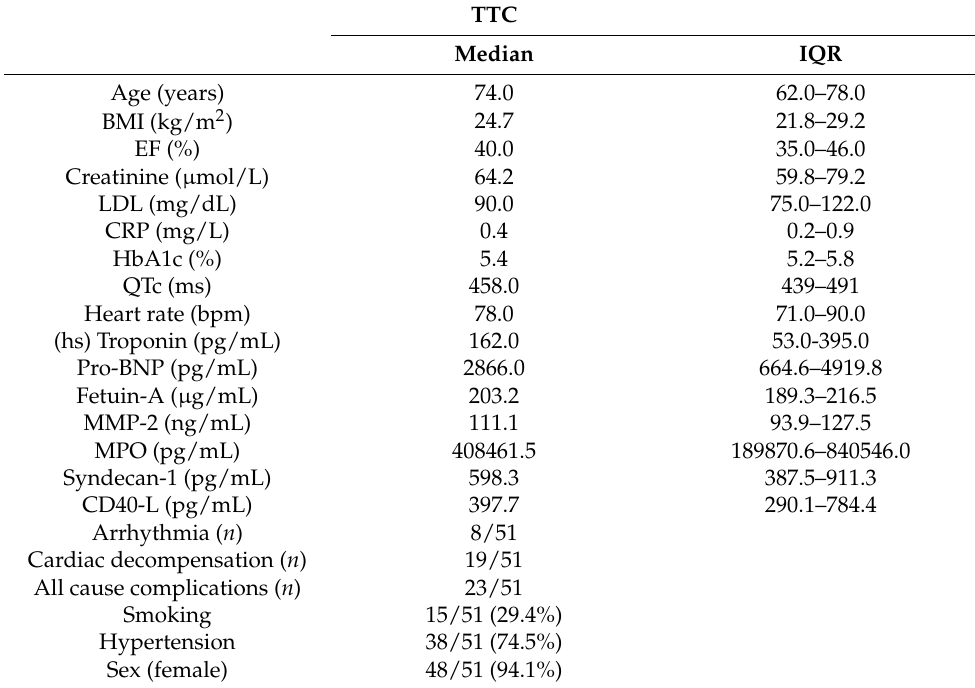
Table 1. Baseline characteristics of all TTC patients, given as median and